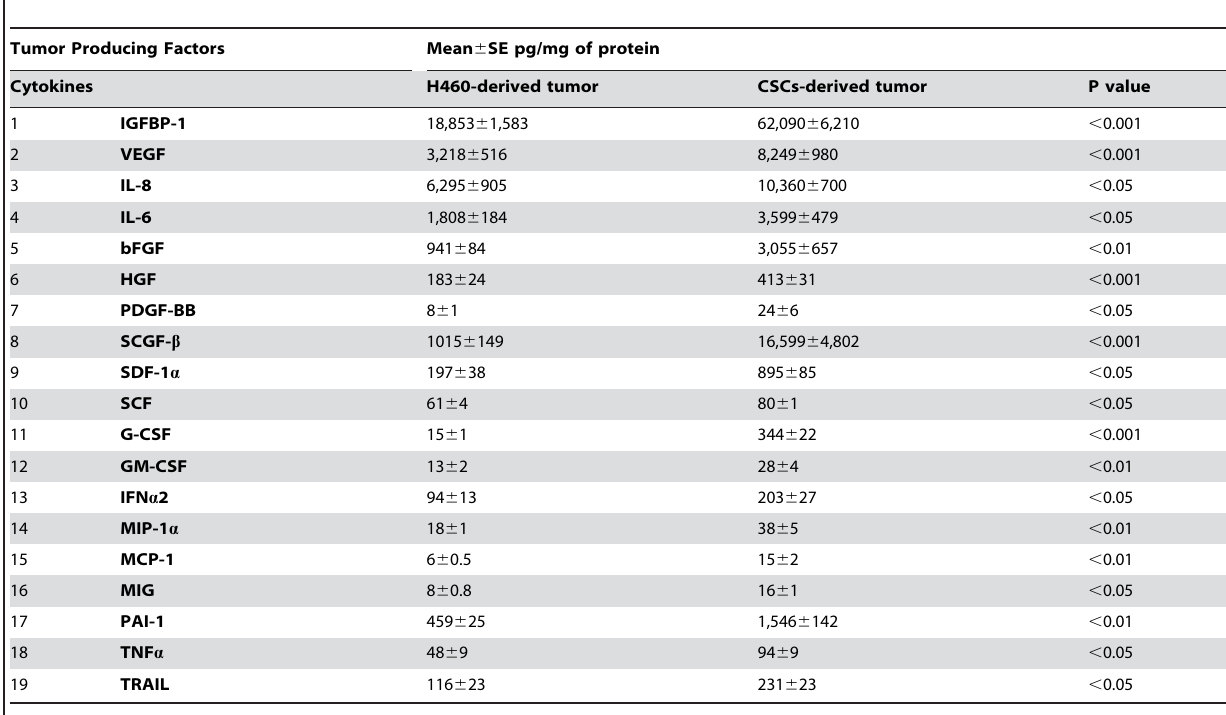
Table 2. Multiplex analysis of cytokines and growth factors in the lysates of xenografted parental H460 and CSC-derived tumors.